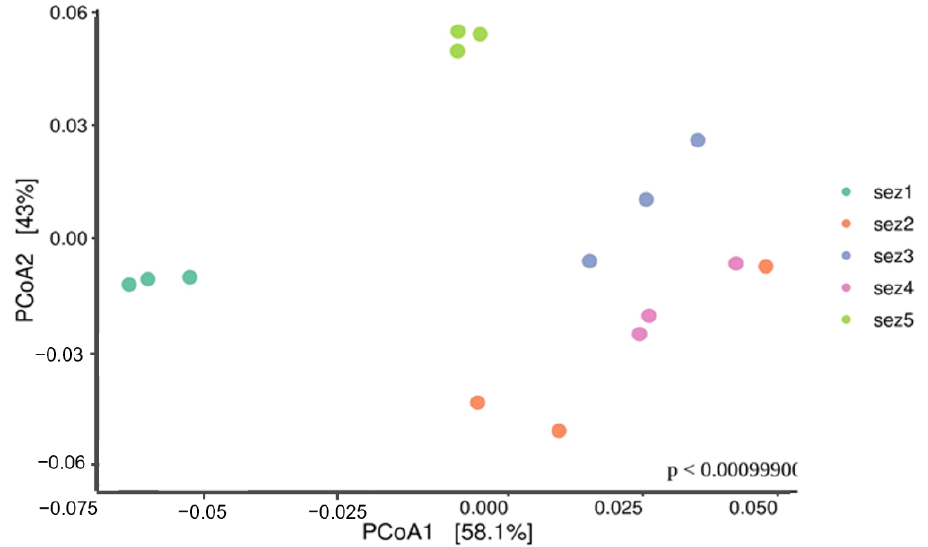
Figure 6. Principal component analysis (PCoA) based on weighted UniFrac distances for each sample replicate. Colors indicate the sampling section of the plug-flow reactor for each data point. The percentage reported on axes represents the amount of total variance depicted by each of them. The p -value was calculated by the ADONIS function (Vegan R package v 2.5 – 7) between weighted UniFrac distances and sample groups using the Bray – Curtis method with 1000 repetitions.